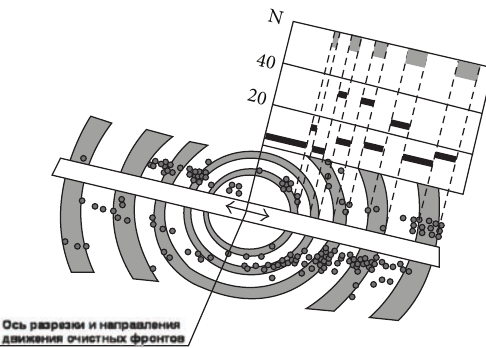
Figure 2: Relationship between the damage of support and the distribution of zonal disintegration